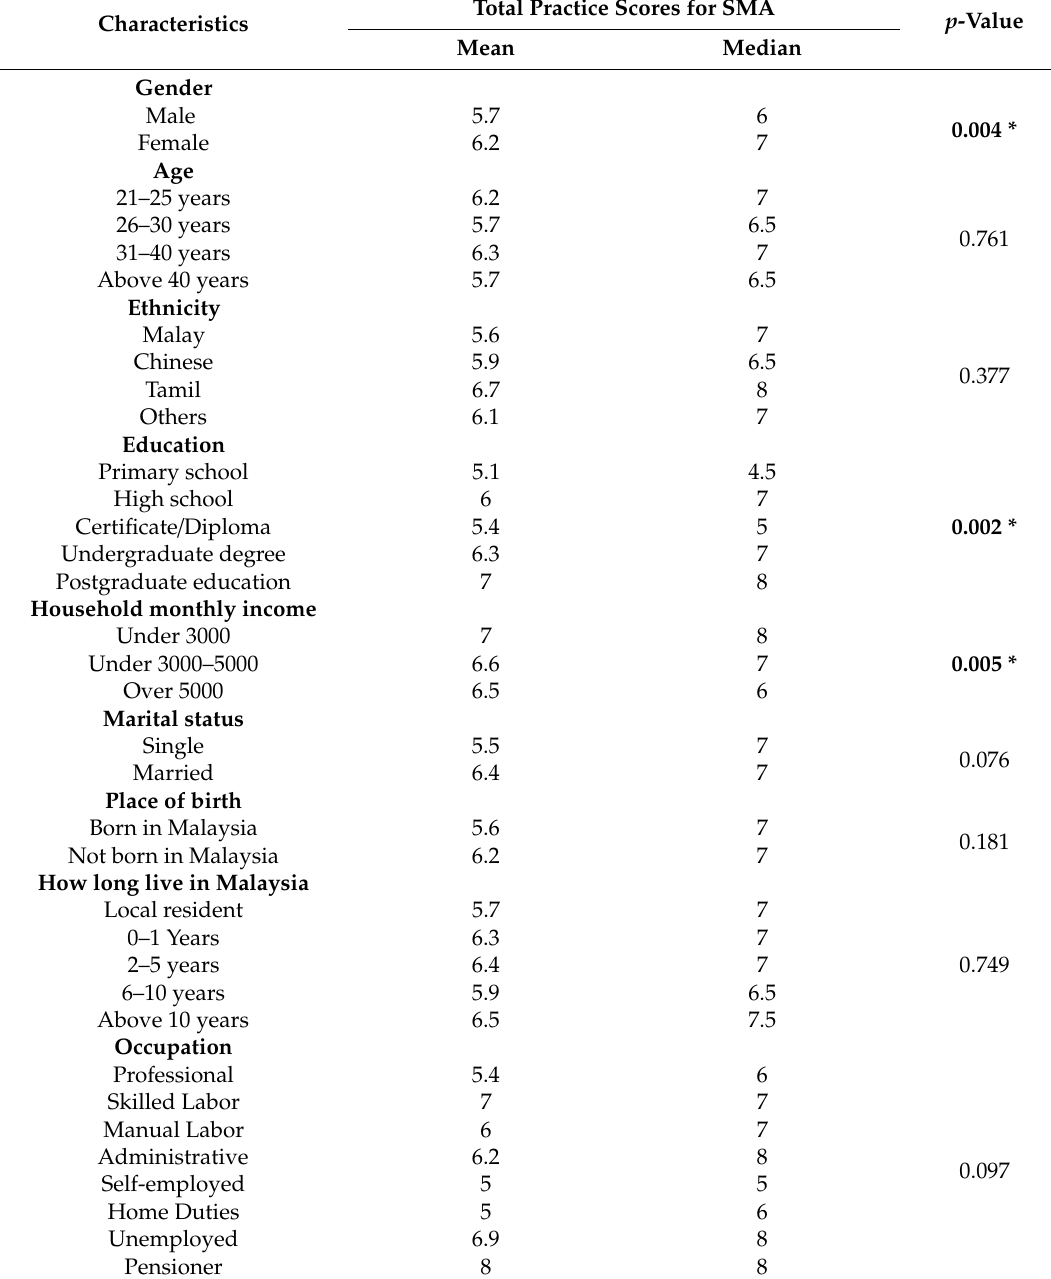
Table 9. Association of demographic characteristics with total practice scores towards